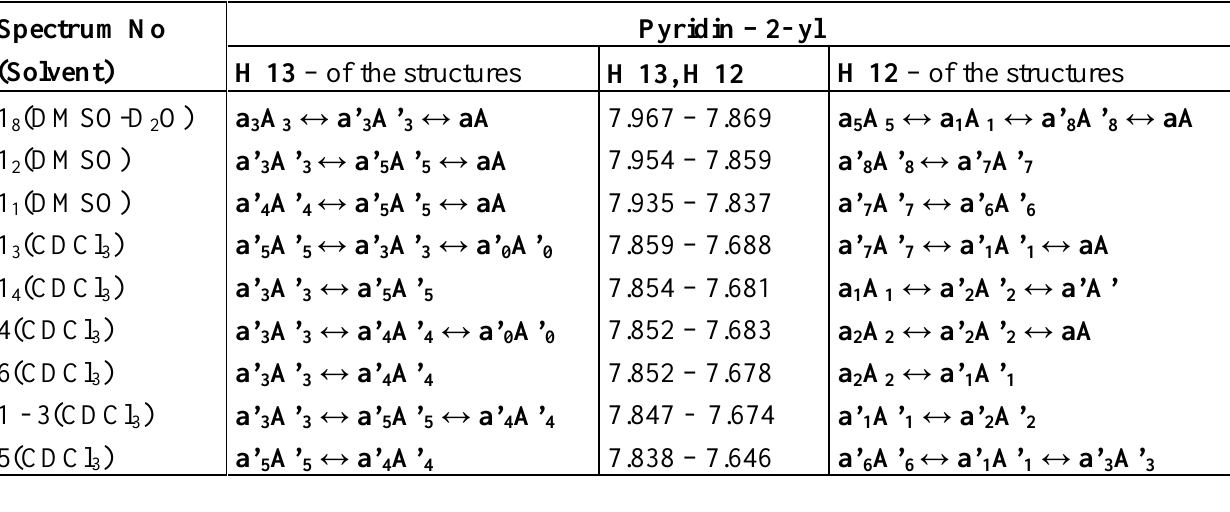
Table 6 . The 1 H-NMR chemical shifts δ [ppm] from TMS of 1